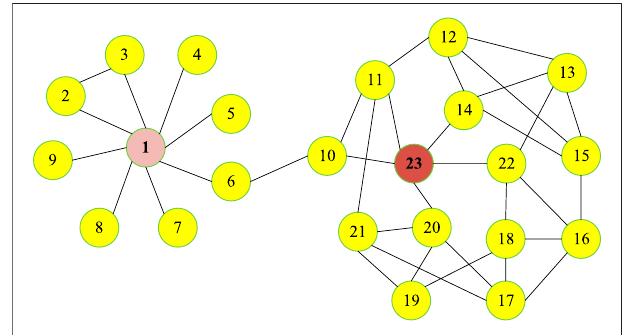
FIGURE 3 | Illustration of user in fl uence